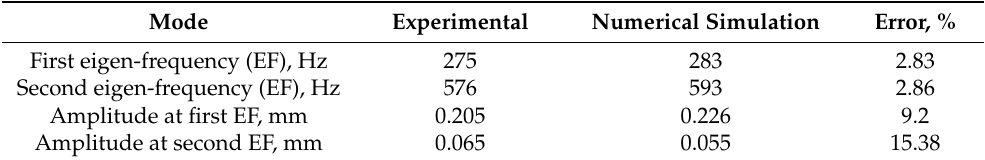
Table 4. Comparison of results.